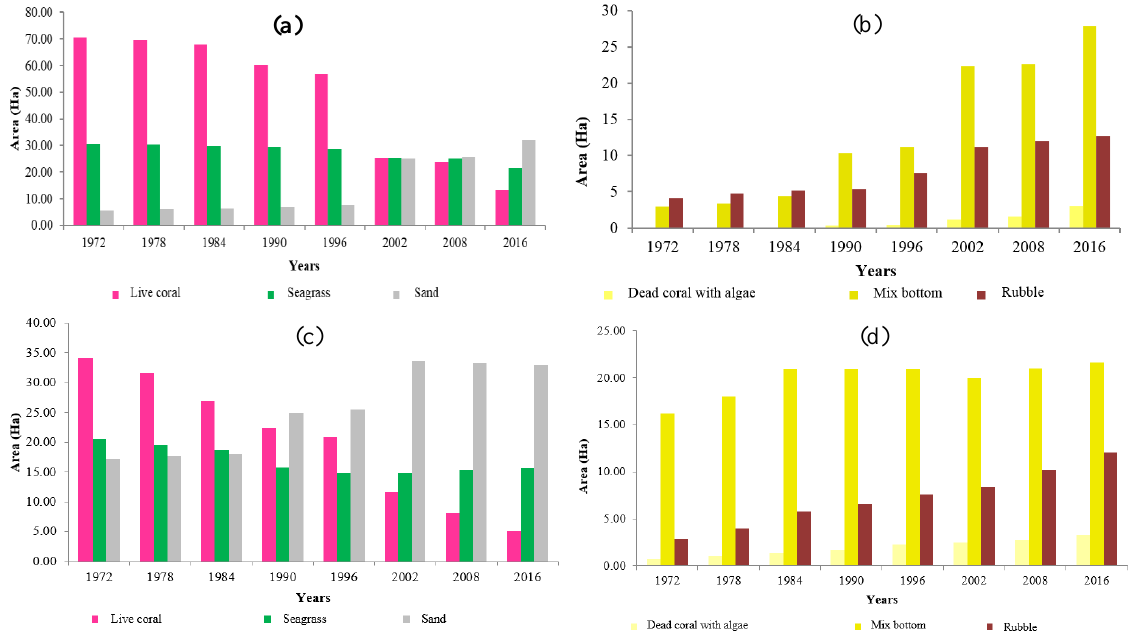
Figure 3. Graph of spatial dynamic of shallow water in Bontosua and Ballang Caddi island, (a) area of live coral, seagrass and sand in Ballang Caddi island, (b) area of dead coral with algae, mix bottom, and rubble in Ballang Caddi island, (c) area of live coral, seagrass and sand in Bontosua island, (b) area of dead coral with algae, mix bottom, and rubble in Bontosua island